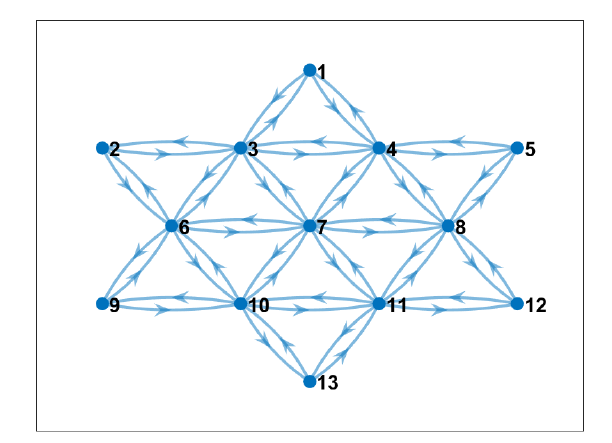
Figure 7. Communication pattern without the proposed communication-reduced method. Nodes broadcast data to their neighbors.